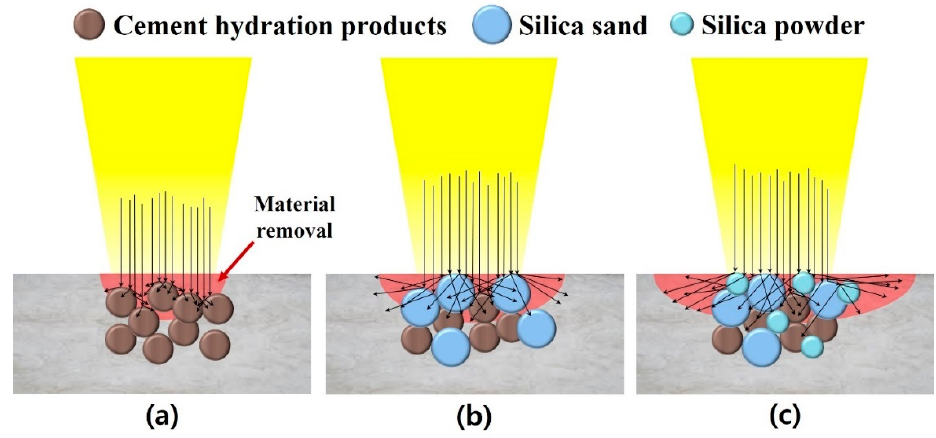
Figure 5. Schematic diagram of material removal mechanisms on ( a ) LP, ( b ) LM, and ( c ) LU.